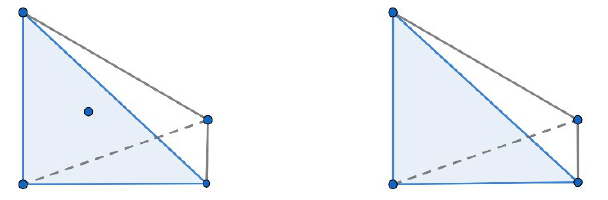
Figure 1. Mini-element 1 / 1 P Bubble P − in 2 D .